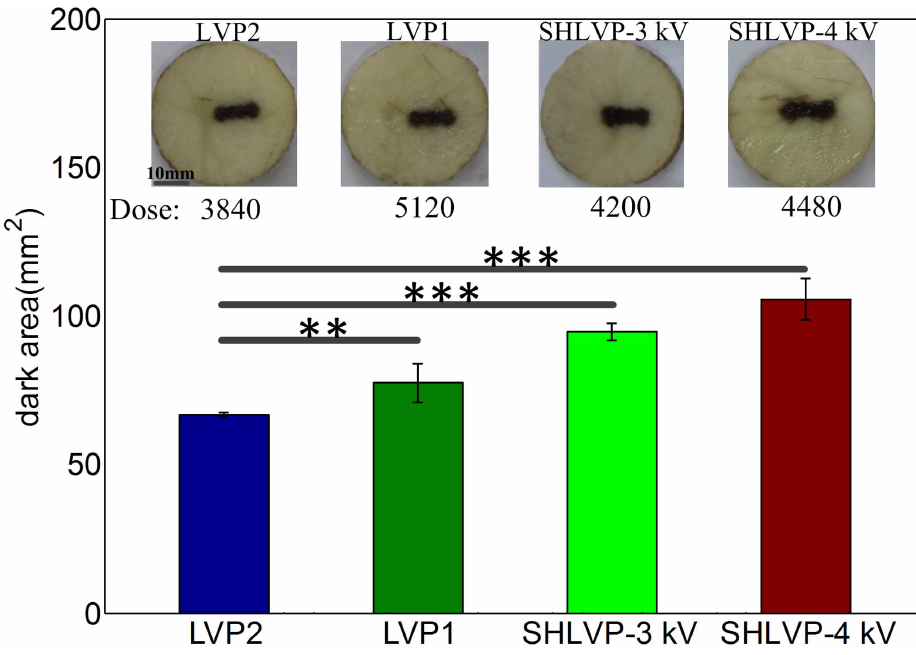
Fig 4. For a lower dose, applying SHLVPs produces a larger ablation area than that of LVP1. The parameters were as follows: LVP2: 0.8 kV/cm, 100 μ s, 60 pulses; LVP1: 0.8 kV/cm, 100 μ s, 80 pulses; SHLVP-3 kV: 3 kV/cm, 2 μ s, 20 pulses+0.8 kV/cm, 100 μ s, 60 pulses; SHLVP-4 kV: 4 kV/cm, 2 μ s, 20 pulses +0.8 kV/cm, 100 μ s, 60 pulses. Data are shown as the average ± SD; ( ** , p < 0.01)and ( *** , p < 0.001). Detailedprotocol parameters are shown in Table 3.